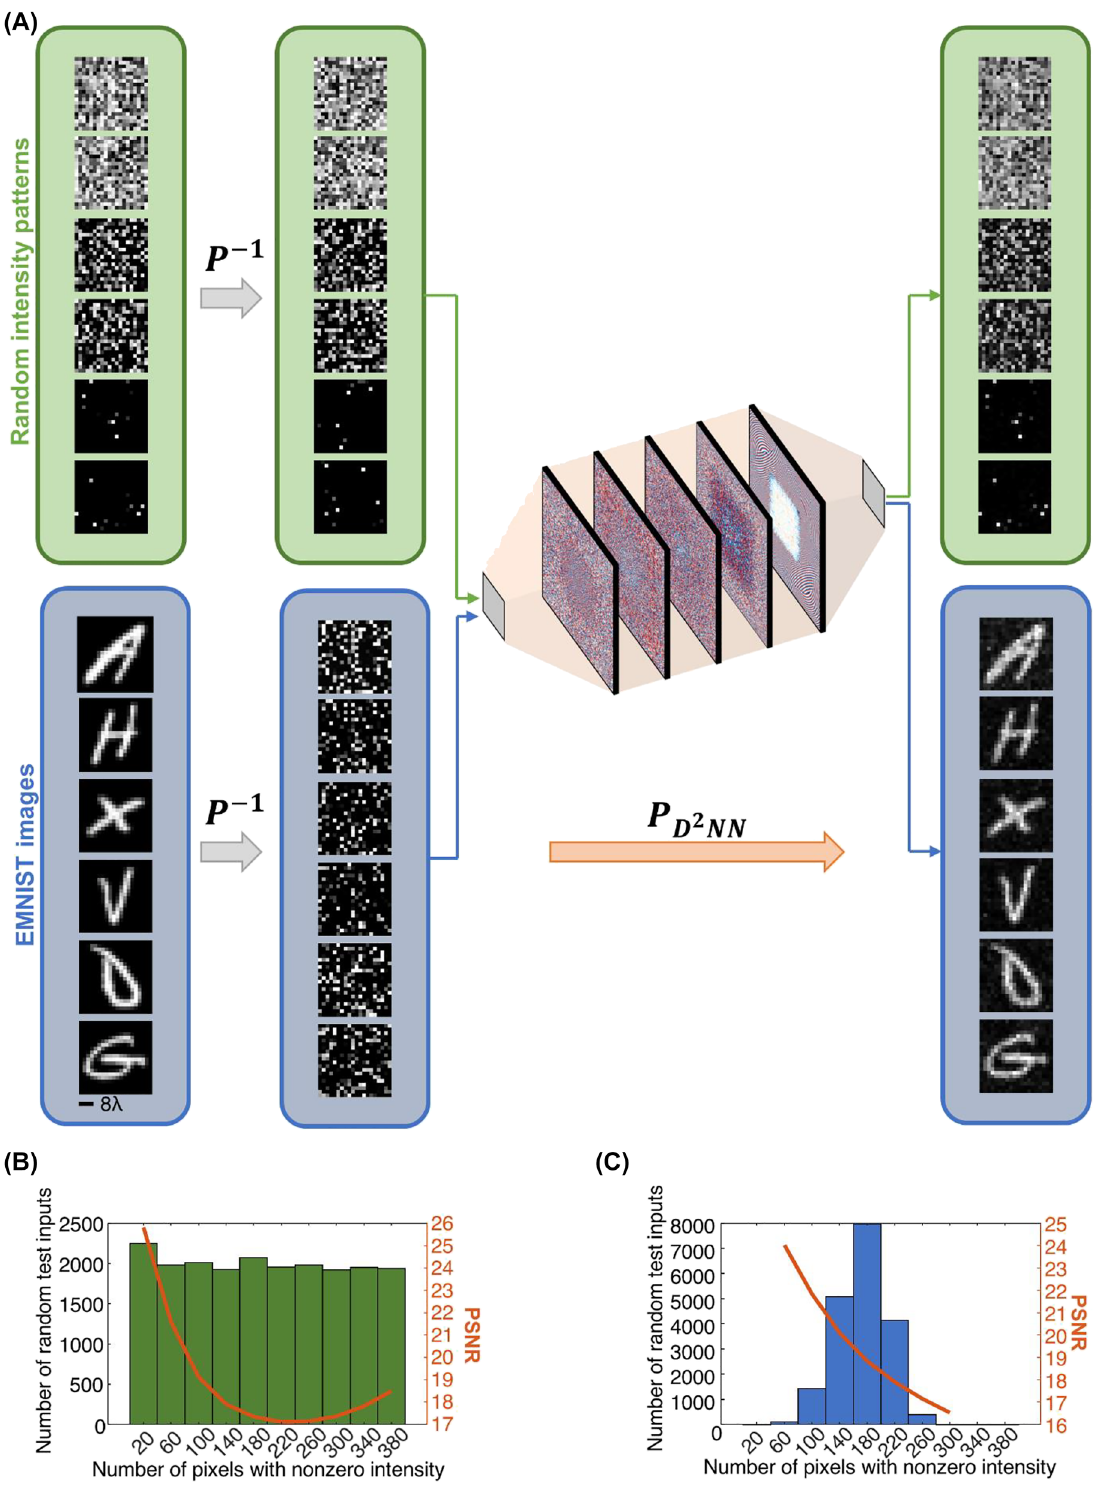
Figure 2: Input–output intensity pairs generated by the diffractive permutation network shown in Figure 1. (A) The diffractive permutation network shown in Figure 1 was tested on two different datasets. The first blind testing dataset contains 20K randomly generated inputs. 6 examples from this randomly created testing data are shown here for demonstrating input–output intensity pairs with low, moderate and high signal sparsity levels. Beyond successfully permuting randomly generated intensity patterns, the performance of the diffractive permutation network was also quantified using permuted EMNIST images. None of these test samples were used in the training phase. (B) Output intensity image PSNR with respect to the ground truth intensity patterns as a function of the input signal sparsity in randomly generated test dataset. (C) Same as (B), except for EMNIST test